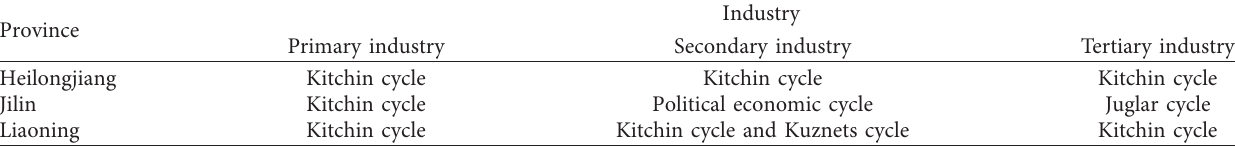
Table 6: Main fluctuation components of each industry in the three northeastern provinces (except trend